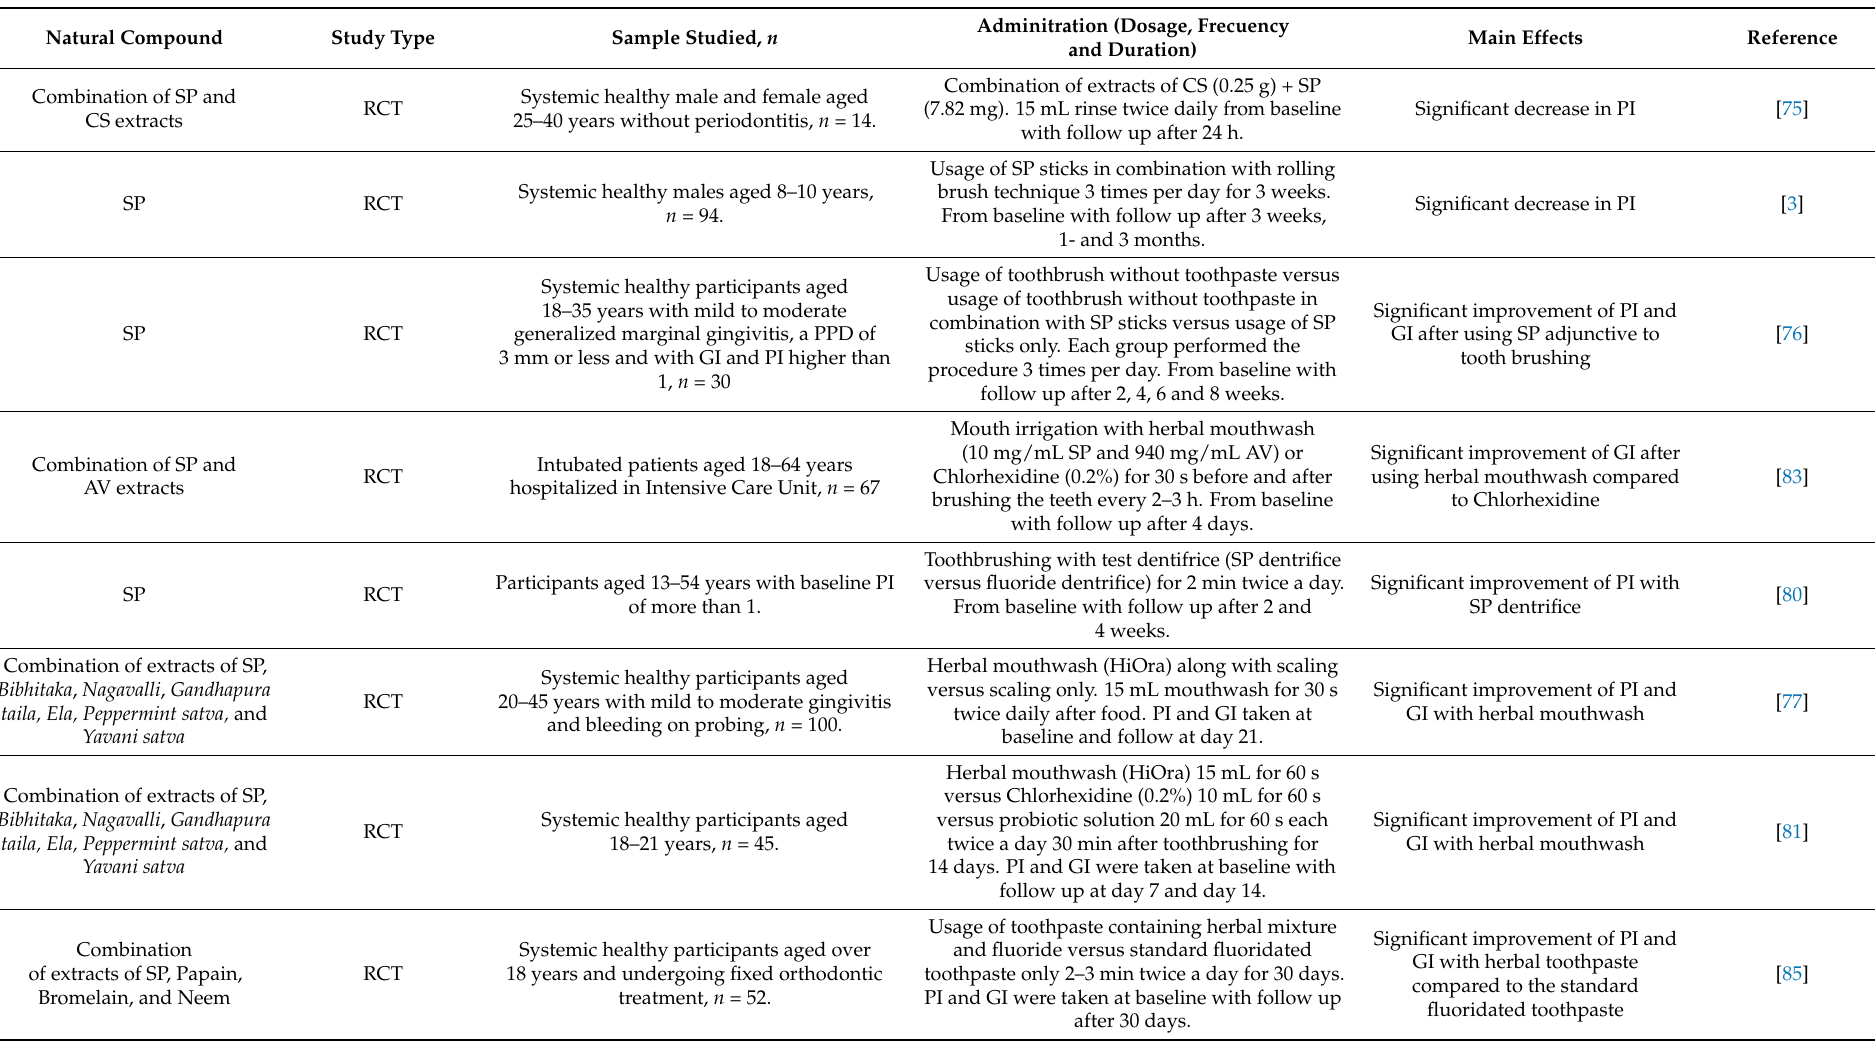
Table 4. Main studies in relation to Salvadora persica of interest in periodontal health and